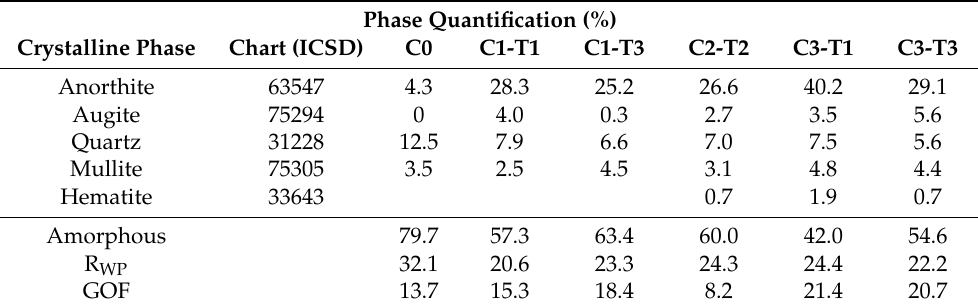
Table 6. Phase quantification of the studied compositions obtained by Rietveld refinement.